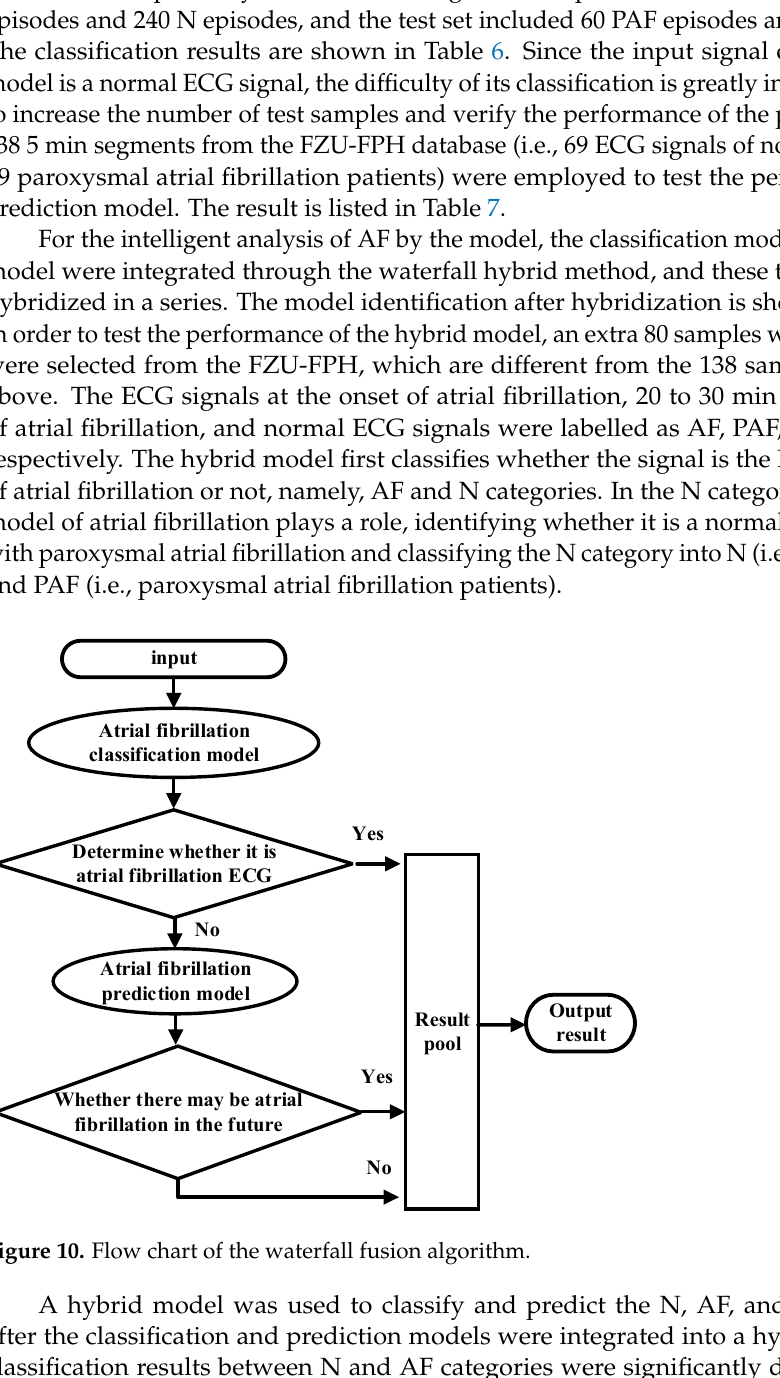
Table 9. Performance of different models in different test sets. Performance of Atrial Fibrillation Classification Models in the AFDB Test Set. SE